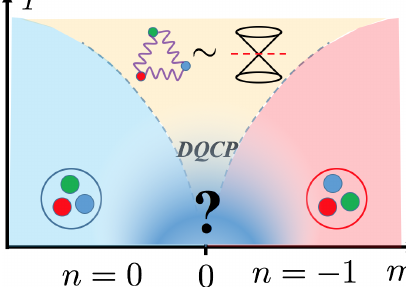
FIG. 9. The transition between the n ¼ 0 state and the n ¼ − 1 state can happen in two ways. One way is a free fermion transition with a single gapless Dirac fermion as the critical theory. The other way is through a strongly coupled non-Abelian gauge theory, which we label SU ð 2 Þ (cid:4) þ N A ¼ 1 . A very exciting f possibility is that the two 3 þ 1 -D conformal field theories are dual to each other in the infrared limit. Unfortunately, this is not likely the case. We argue that a possible IR theory is a single Dirac fermion plus a topological field